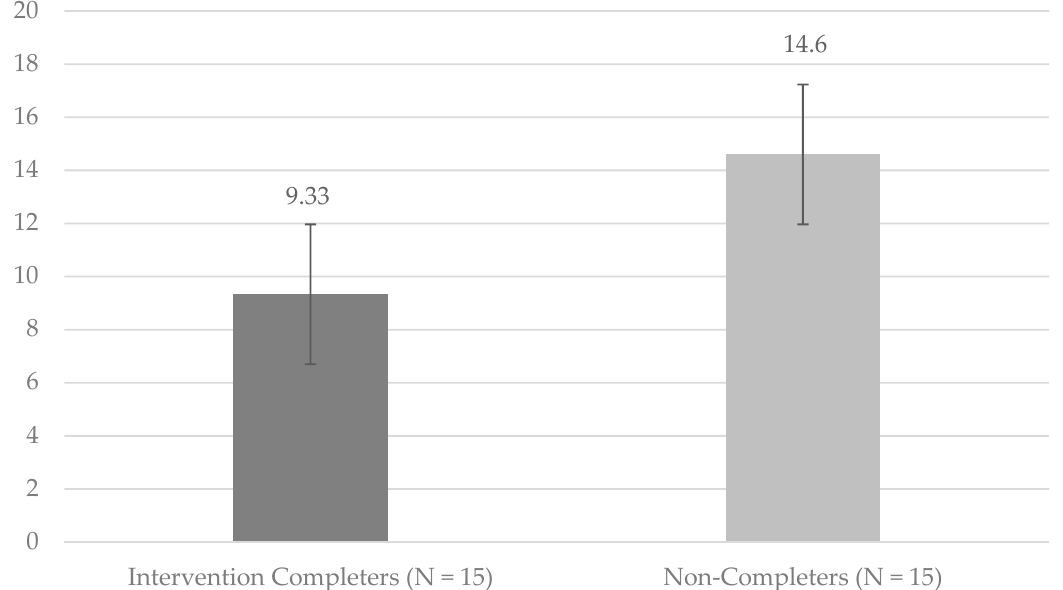
Figure 1. Baseline means and standard errors for perceptions of physical appearance. Note. On the SPPA PA scales, lower scores are indicative of more negative perceptions of physical appearance, and higher scores indicative of positive perception of physical appearance.